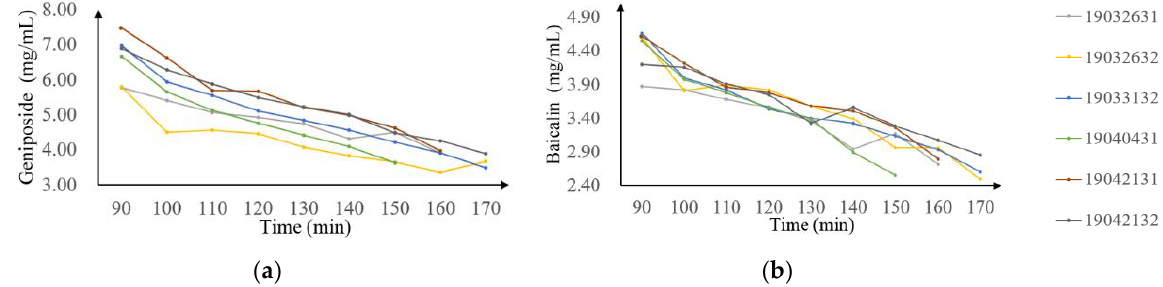
Figure 1. Concentration dynamics of 2 chosen marking components during alcohol precipitation.